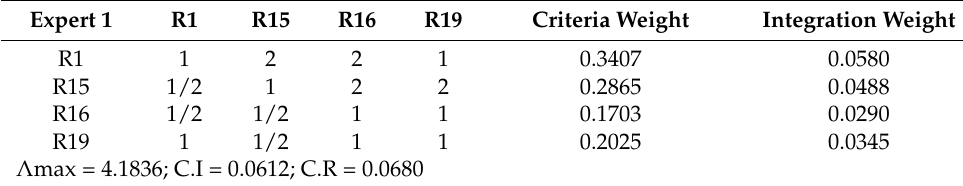
Table 10. The consistency and weight value of enterprise product supply (RA3) factors. Expert